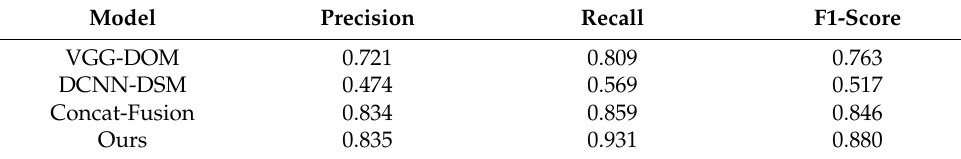
Table 3. Performance comparison of benggang and non-benggang samples.